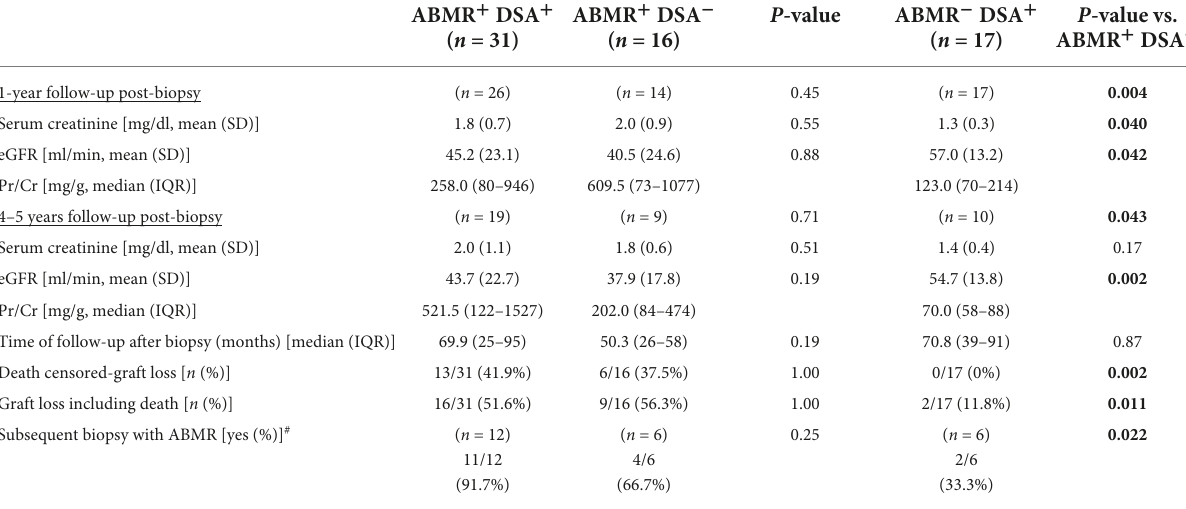
TABLE 4 Clinical follow-up of patients with ABMR and DSA compared to ABMR without HLA-DSA (left) and to non-ABMR with HLA-DSA